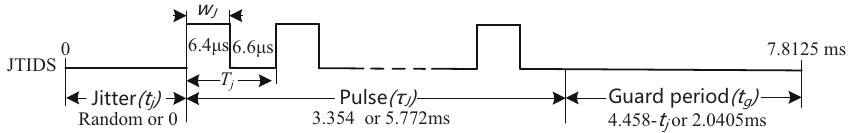
Figure 2. The time distribution of a JTIDS slot.